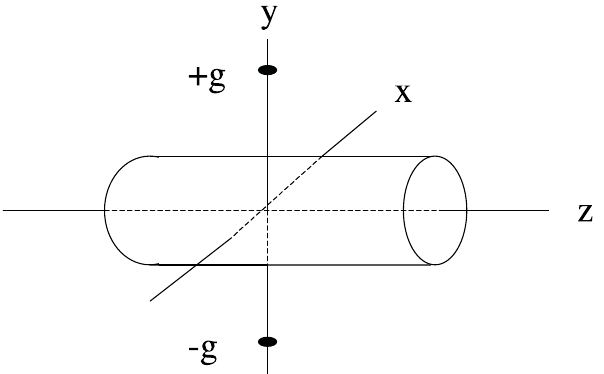
FIG. 6. A monopole doublet consisting of two magnetic mono- poles of equal and opposite sign placed on the y axis and centered on the origin. Also shown, for future reference, is a cylinder with circular cross section placed in the interior field.